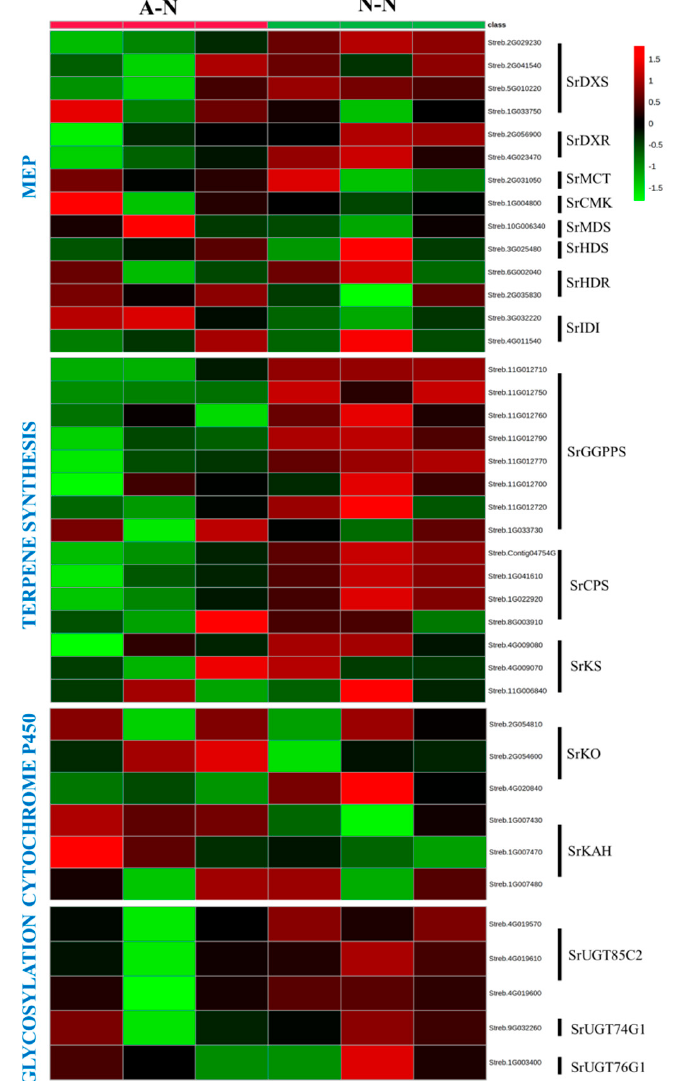
Figure 5. Heatmap showing the expression profiles of the genes involved in steviol glycosides synthesis in ammonium (A-N)- and nitrate (N-N)-treated stevia leaves.